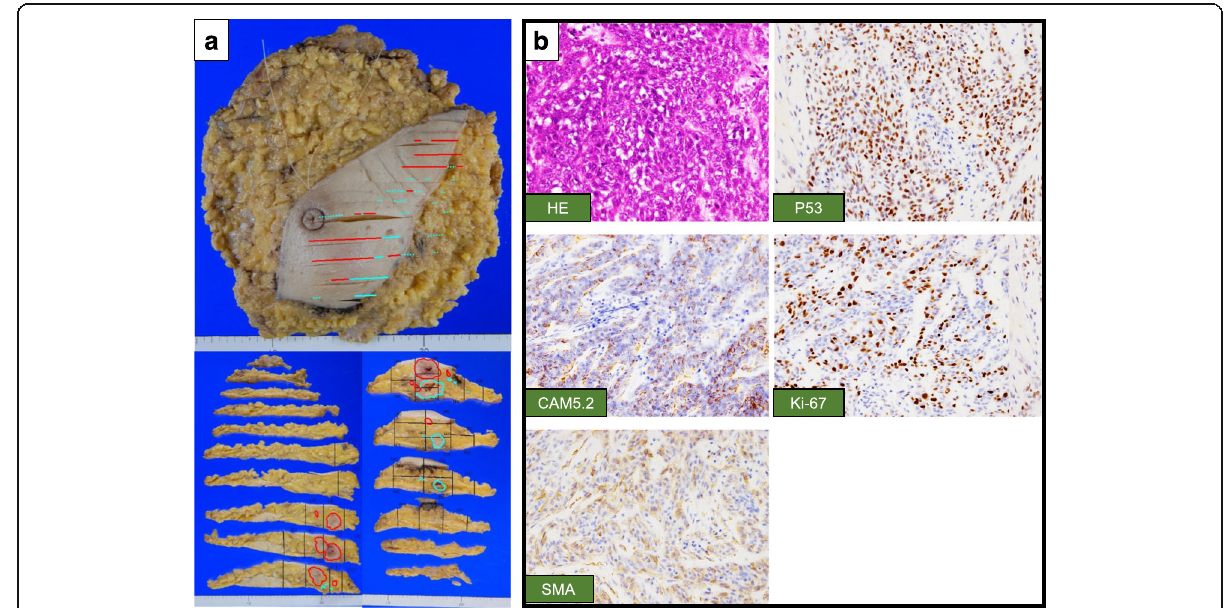
Fig. 3 Histopathology of the malignant adenomyoepithelioma. a Gross specimen of malignant AME. Red markers show malignant lesions, and blue markers show ductal lesions. The size of tumor was 110 × 105 × 55 mm. b Histopathology of the malignant AME. The tumor was consisted of both epithelial cells, which was positive for CAM 5.2, and myoepithelial cells, which was positive for α -smooth muscle actin (SMA). Ki-67 labeling index (Ki-67) was 44%. The myoepithelial cells were strongly positive for P53. × 200